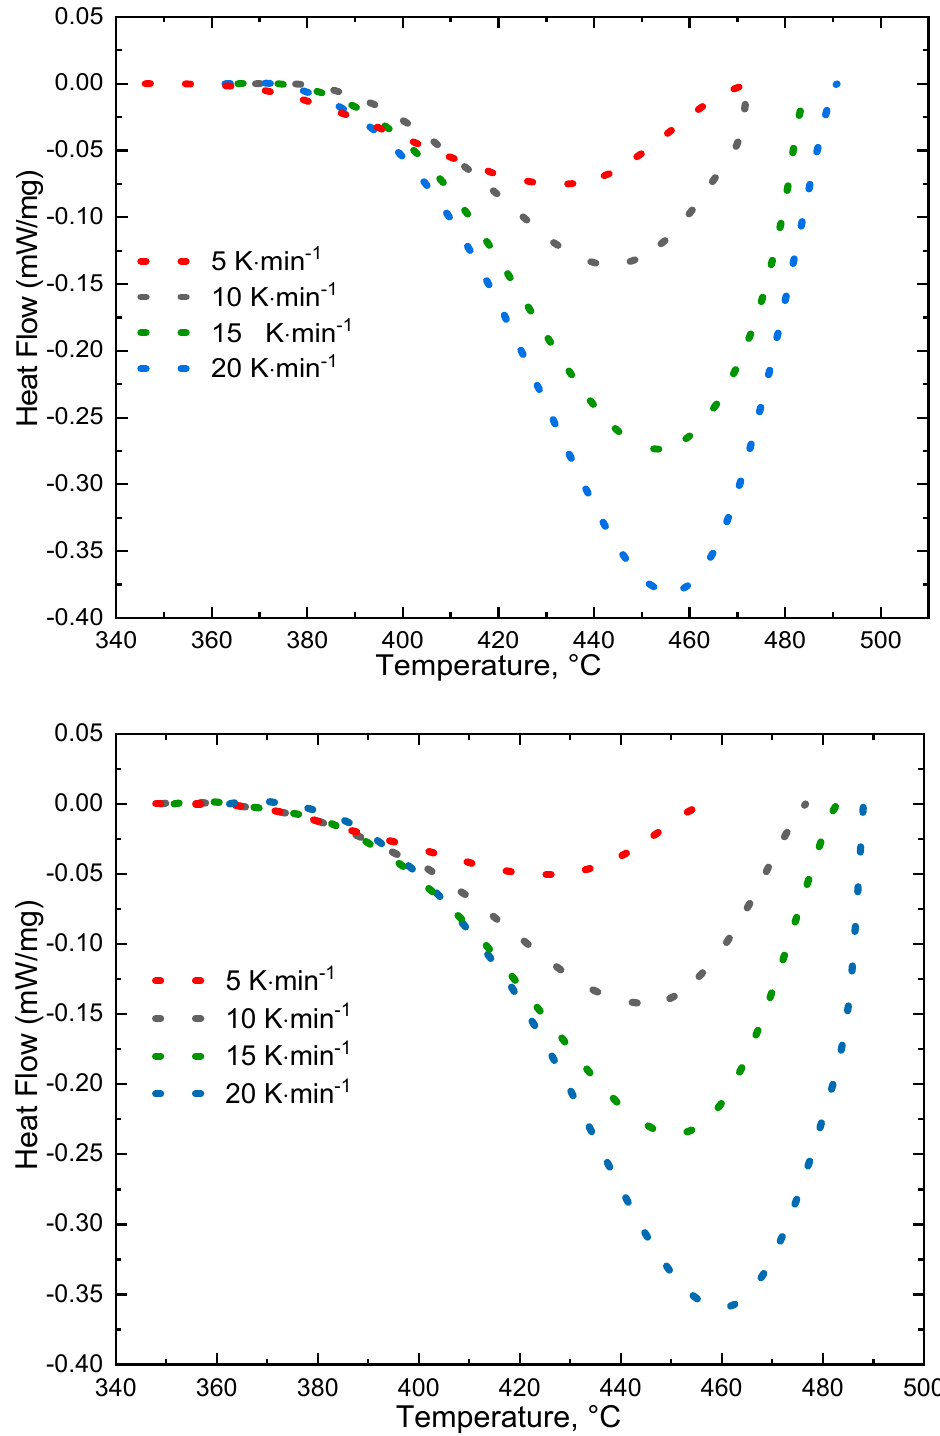
Figure 2. DSC curves for the process of extra-heavy oil pyrolysis in the absence ( Top ) and in the presence ( Bottom ) of iron tallates.